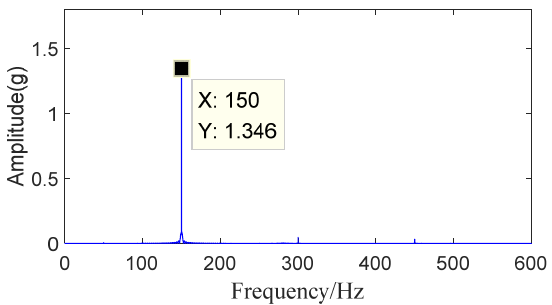
Figure 12. Vibration response of galvanized iron clamp with a 200- μ m-thick hard coating of Al-Cu- Fe-Cr under 150 Hz fixed-frequency excitation.